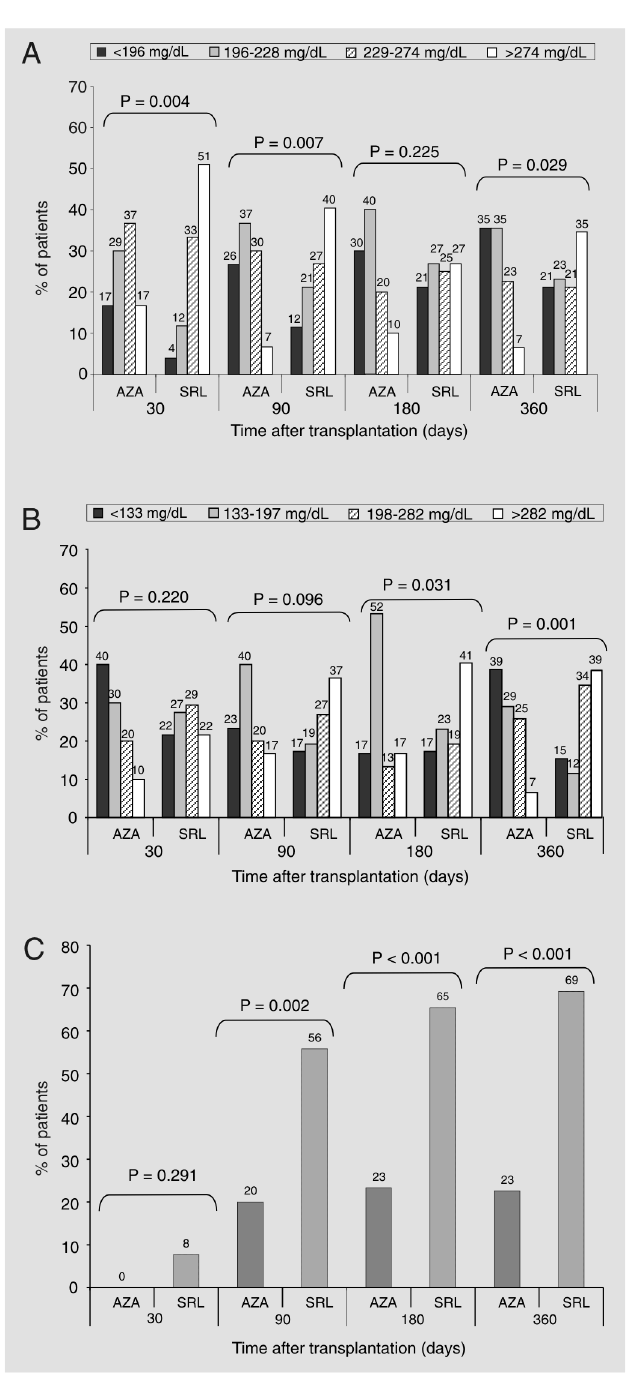
Figure 1. Comparison of the proportion of serum cholesterol (A) and triglyceride (B) concentrations, according to interquartile ranges, in pa- tients receiving azathioprine (AZA) or sirolimus (SRL). Unpaired independ- ent Student t -test was used to determine statistical significance between mean in each study visit. C , Comparison of the proportion of patients in each group (AZA or SRL) receiving statins. Exact chi-square test was used to determine statistical